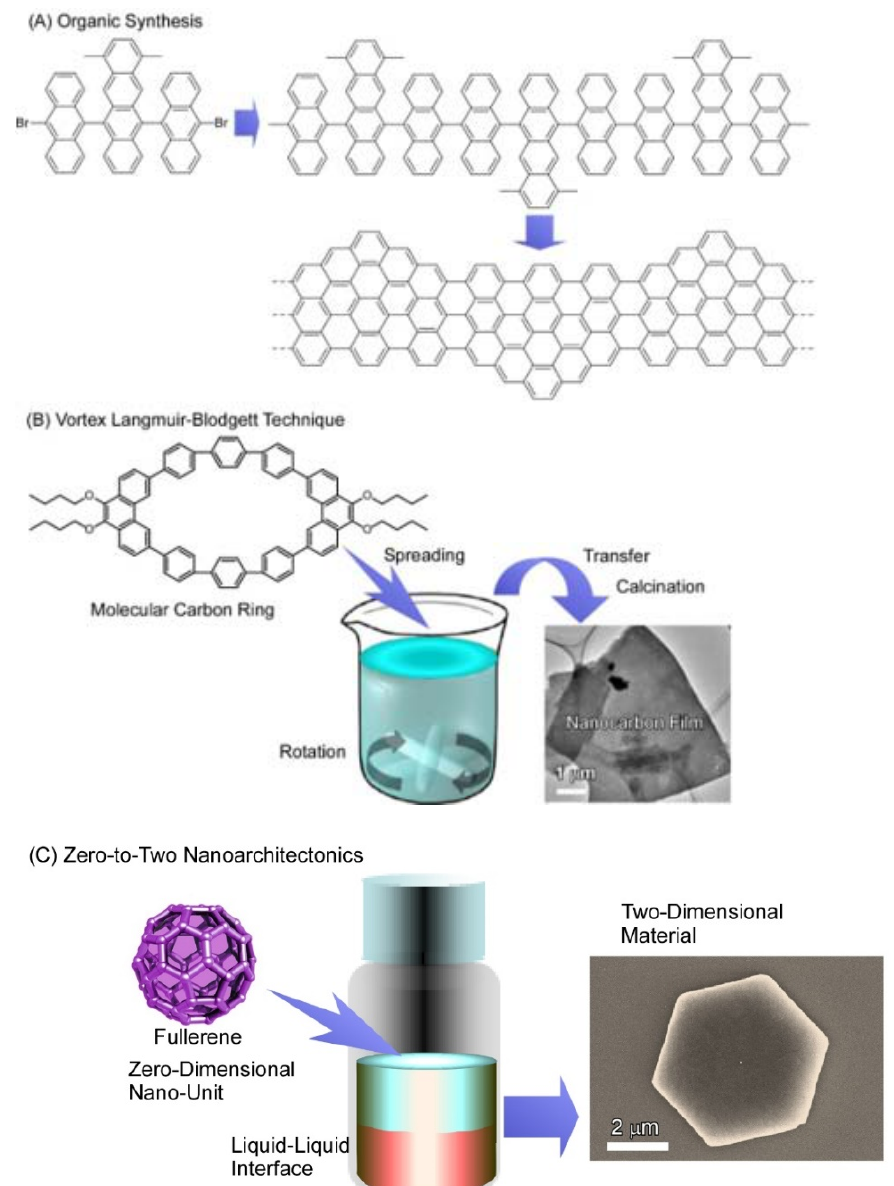
Figure 2. Emerging methods for the fabrication of two-dimensional carbon materials; ( A ) organic synthesis; ( B ) vortex Langmuir–Blodgett technique; ( C ) zero-to-two nanoarchitectonics (through liquid–liquid interfacial precipitation method).